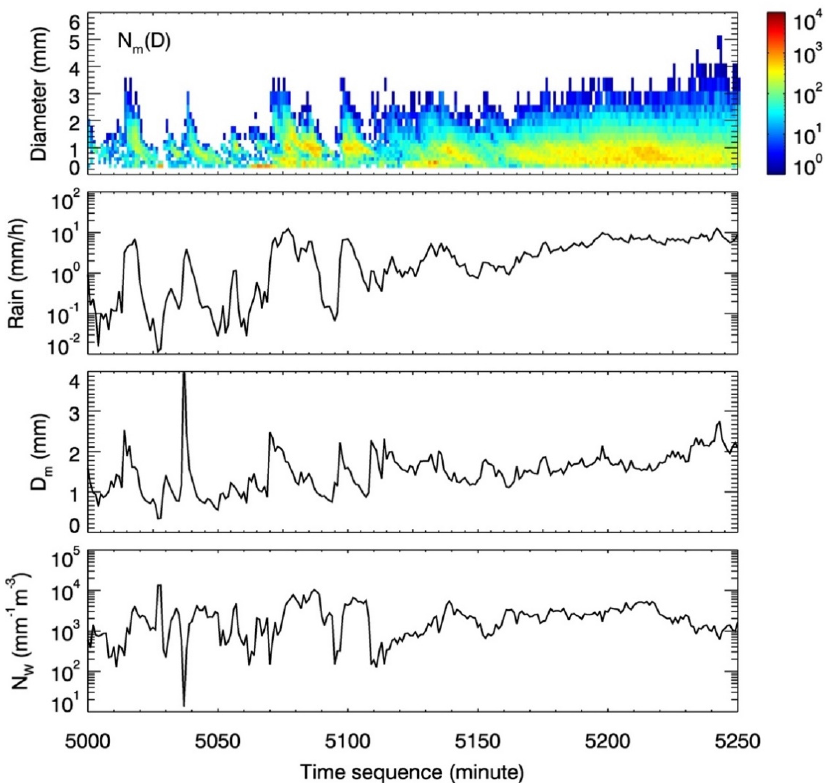
Figure 1. Example of the time-series droplet-size distribution (DSD) measurements from the time stamp 5000–5250, a total of 250 min. The size spectra are given in the top panel while rainfall rate R, mass-weighted diameter D m and normalized intercept parameter N w , which are derived directly from DSD, are provided in the 2nd, 3rd and 4th panels from the top, respectively.